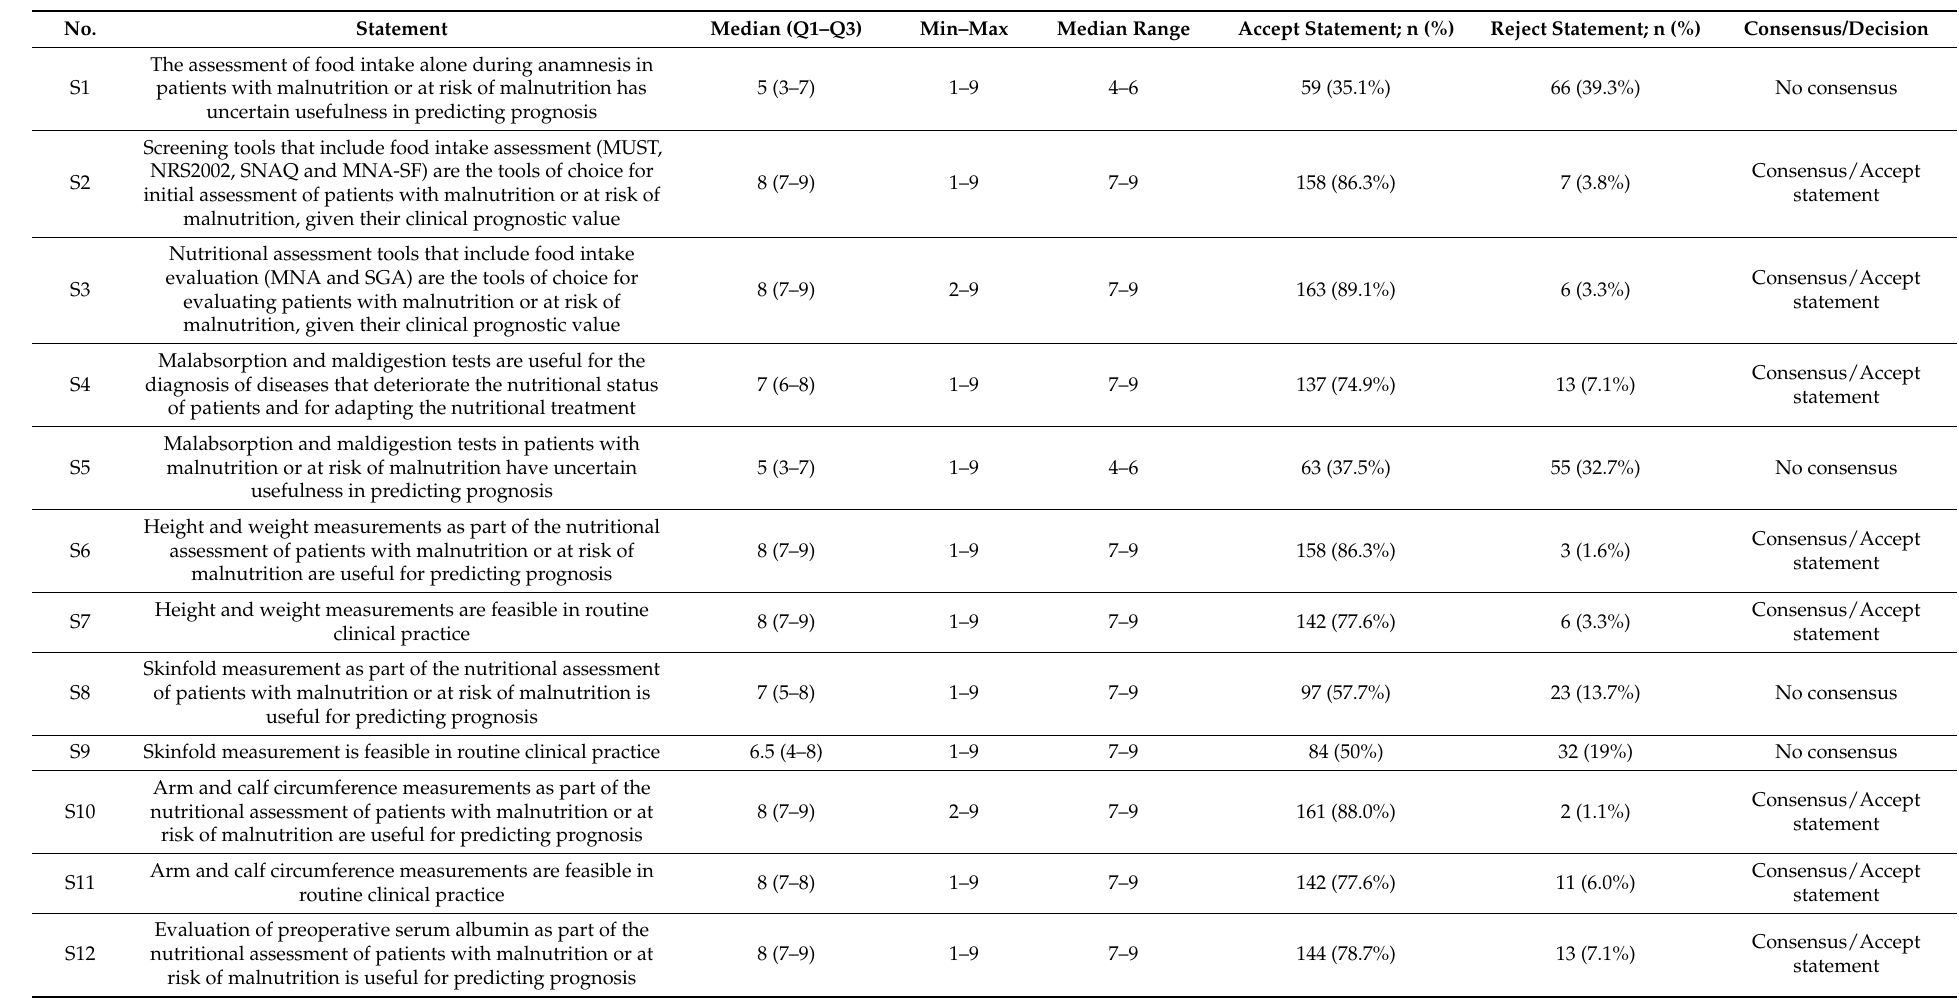
Table 3. Results from Delphi